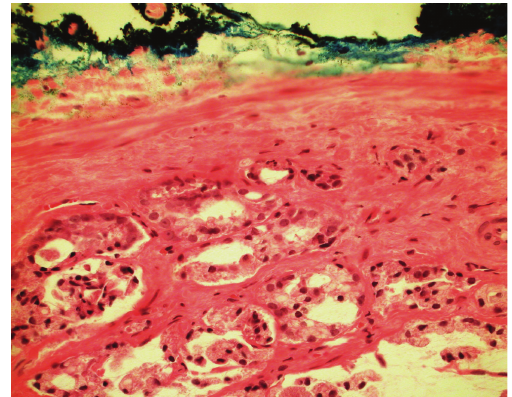
Figure 2: Prostatectomy specimen with negative surgical margin. Tumor approaches within less than 1 millimeter of the inked margin